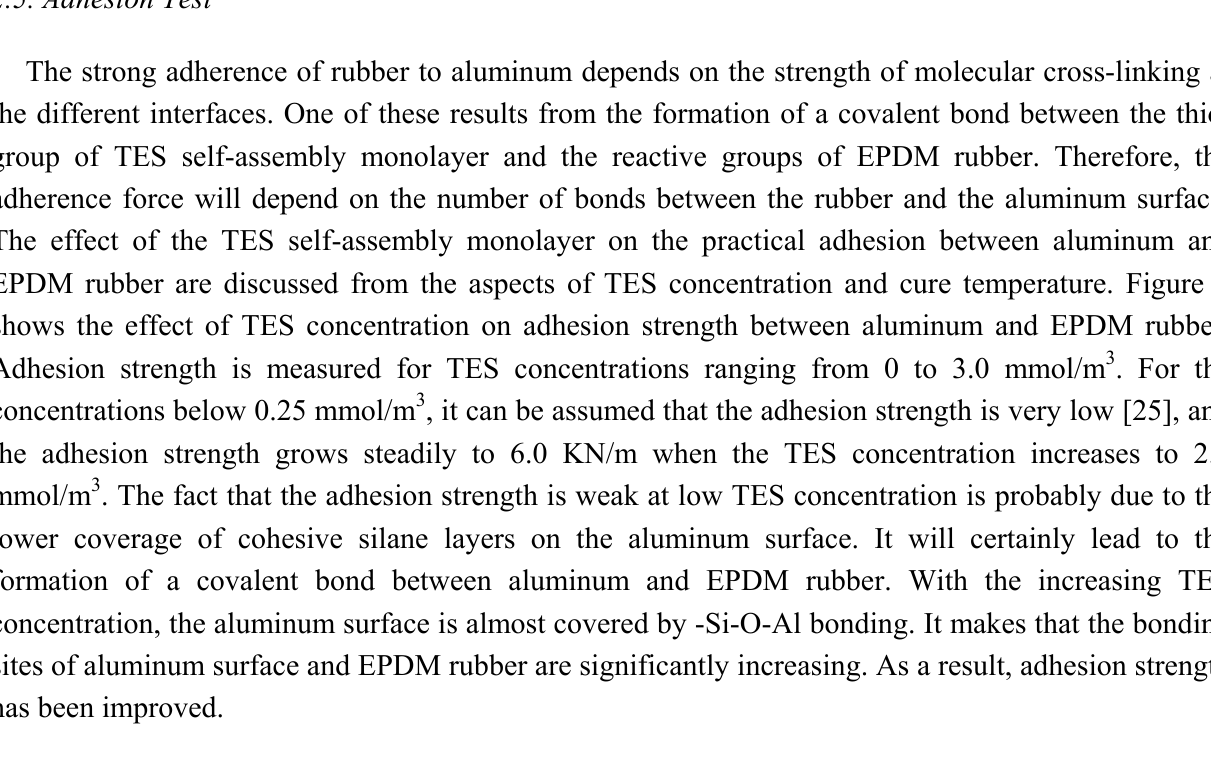
Figure 5. Effect of TES concentration on the adhesion strength between aluminum substrate and EPDM